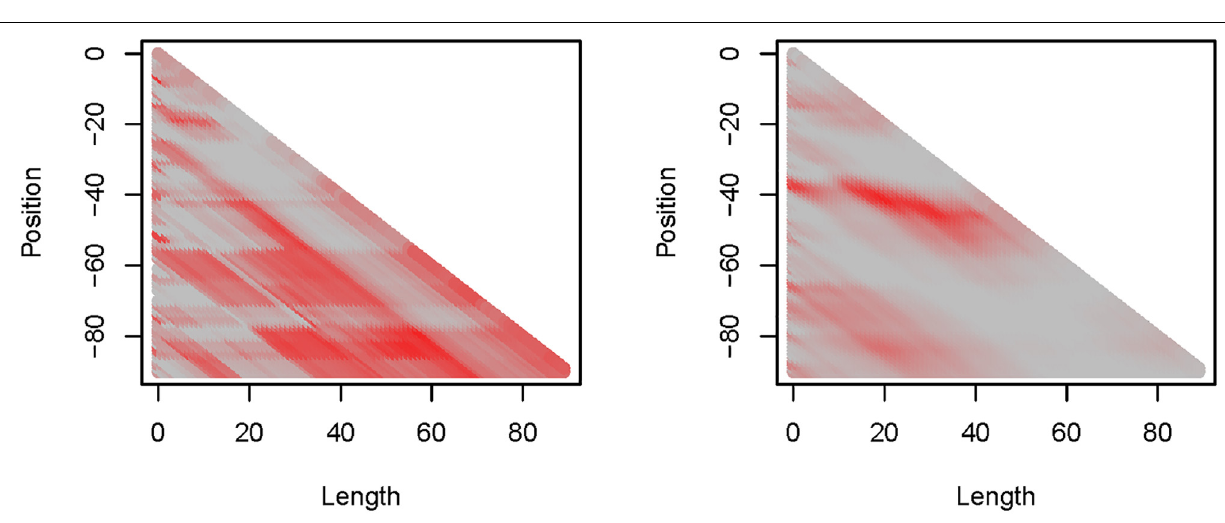
FIGURE 3 | Depiction of R 2 -values derived by the sliding window approach on (left) precipitation (PP) and (right) daily maximum temperature ( T max ). Both show a maximum R 2 = 0.82: PP at length = 58 and position = –79 (approx. 11–3 weeks before egg-laying), T max at length = 20 and position = –40 (approx. 6–3 weeks before